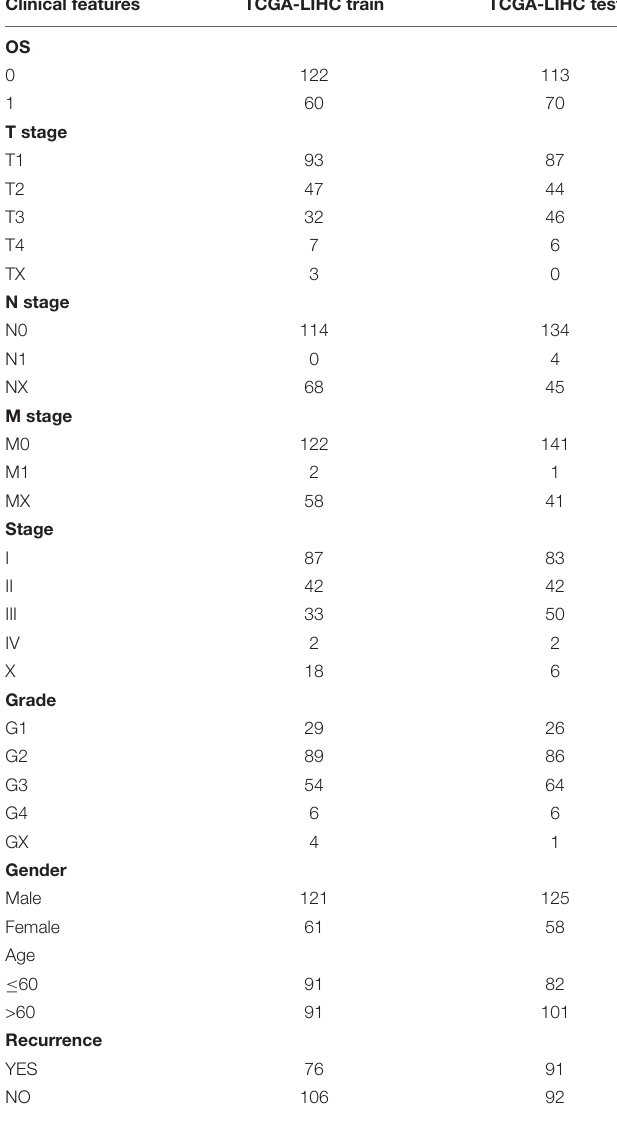
TABLE 3 | TCGA training set and validation set sample information. Clinical